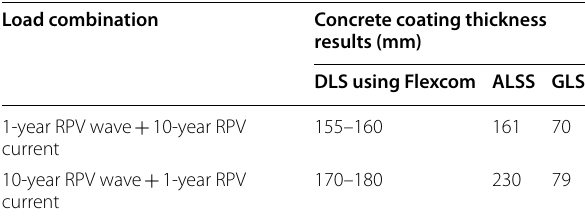
Table 5 Results of comparison between DLS, ALSS, and